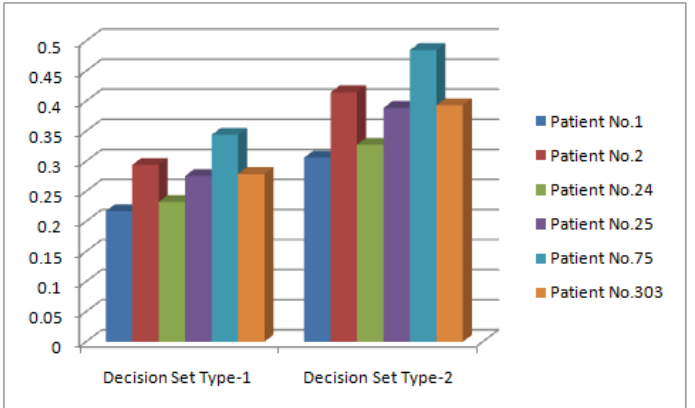
Figure 11. Comparison of Decision Sets of Type-1 and